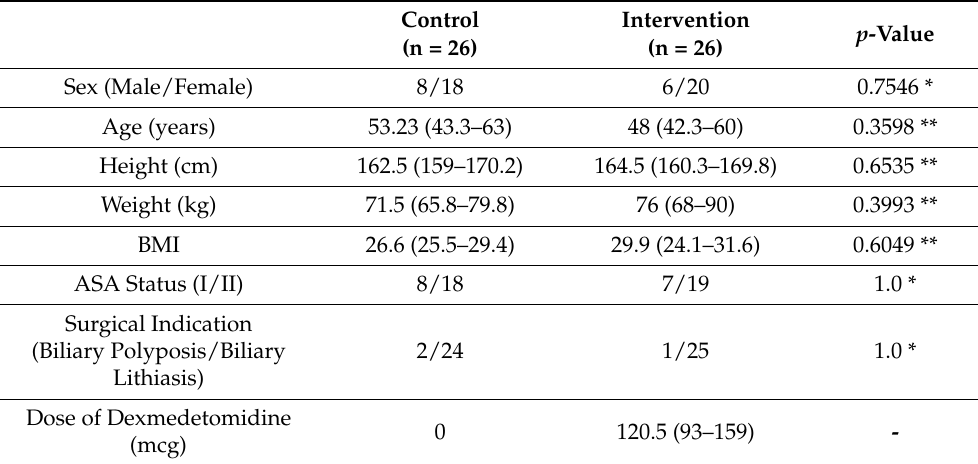
Table 1. Demographics and Clinical